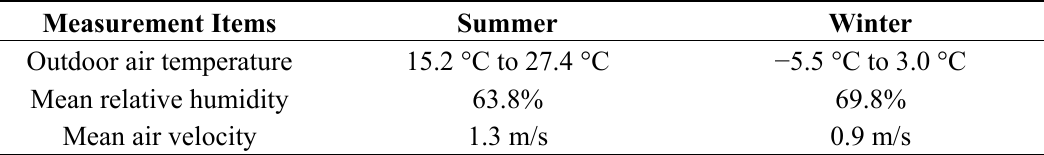
Table 1. Outdoor enviromental parameters for the